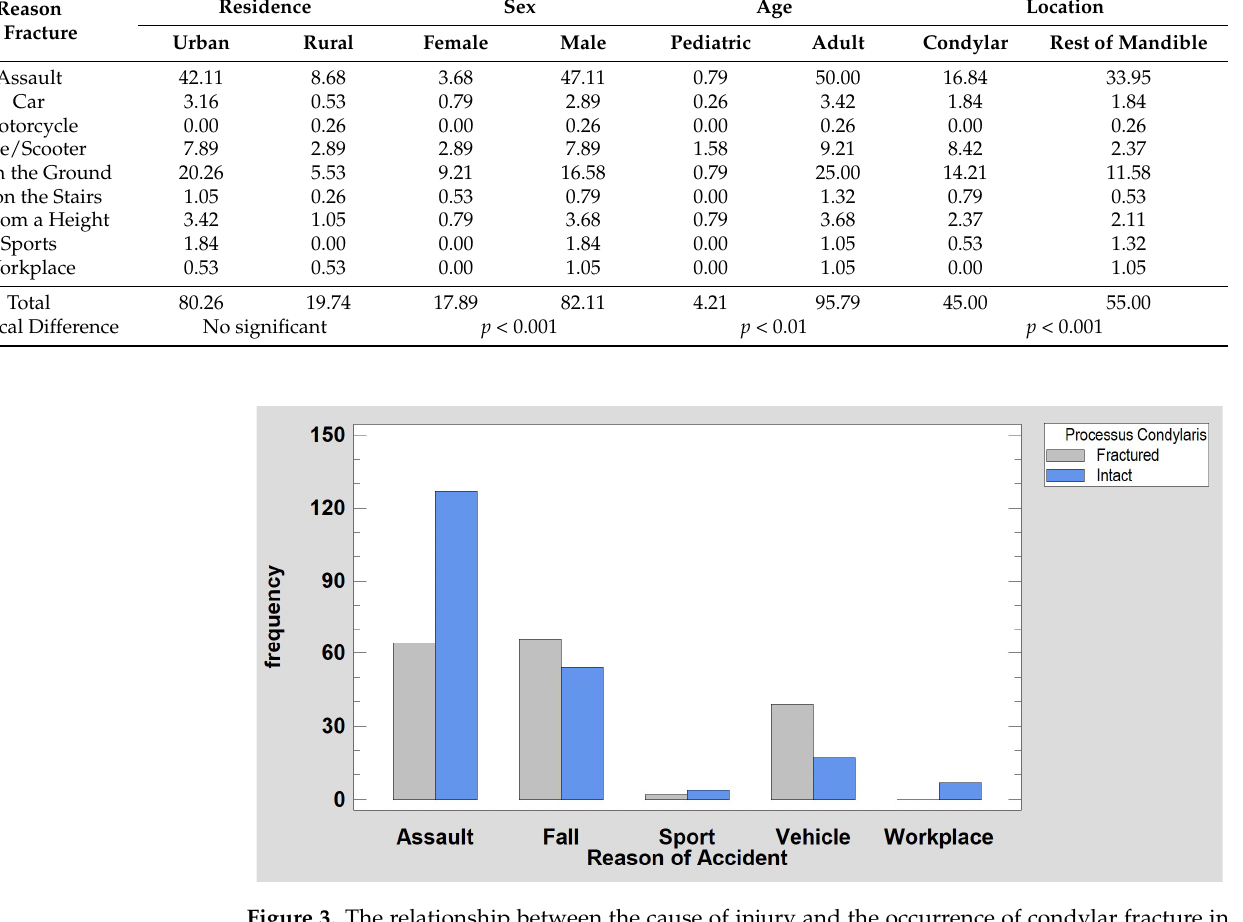
Figure 3. The relationship between the cause of injury and the occurrence of condylar fracture in the mandible. Note that fractures resulting from falls and vehicular accidents are more common ( p < 0.001) than the “intact” status of this anatomical region (i.e., they cause fractures of other parts of the mandible).